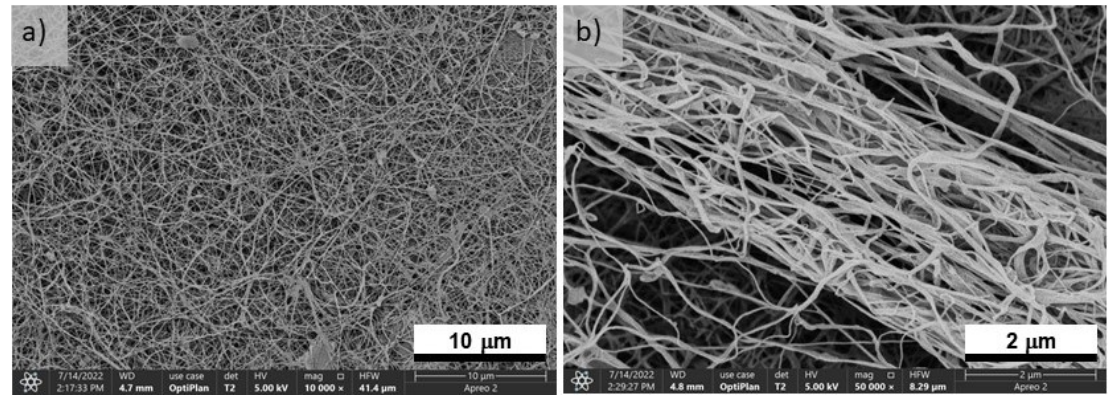
Figure 1. SEM micrographs of freeze-dried BNC at ( a ) ×10,000 and ( b ) ×50,000. SEM micrographs of H 3 PO 4 -activated carbons (P500 and P600) are presented